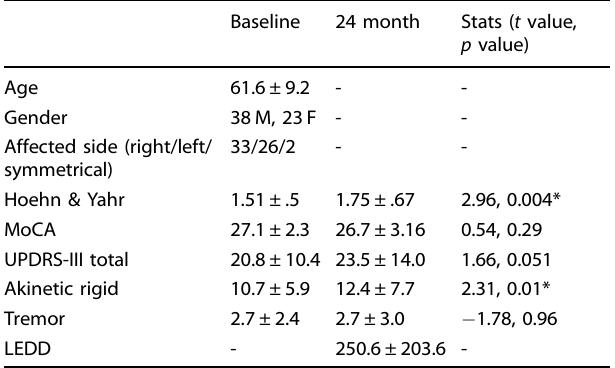
Table 2. Demographic data of all